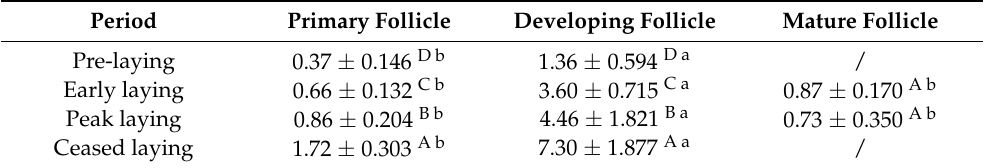
Table 3. The mRNA expression of OVR in different follicles from Wanxi White goose at different laying periods.